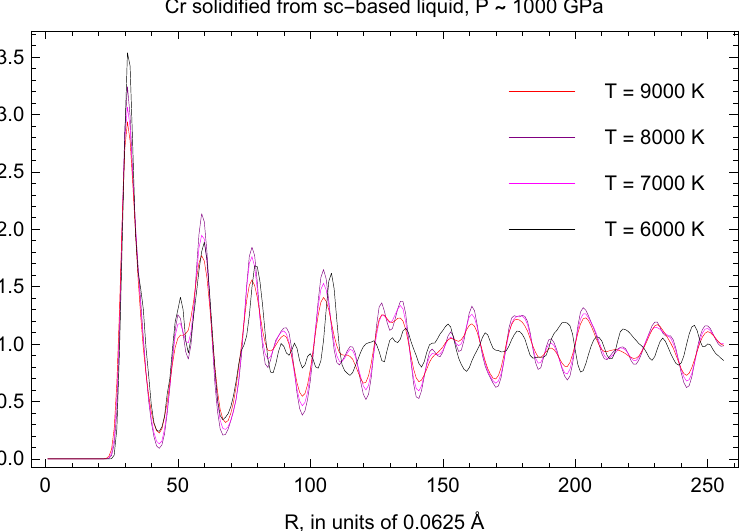
Figure 7. RDFs of the final states of the solidification of liquid Cr at ∼ 1000 GPa at higher